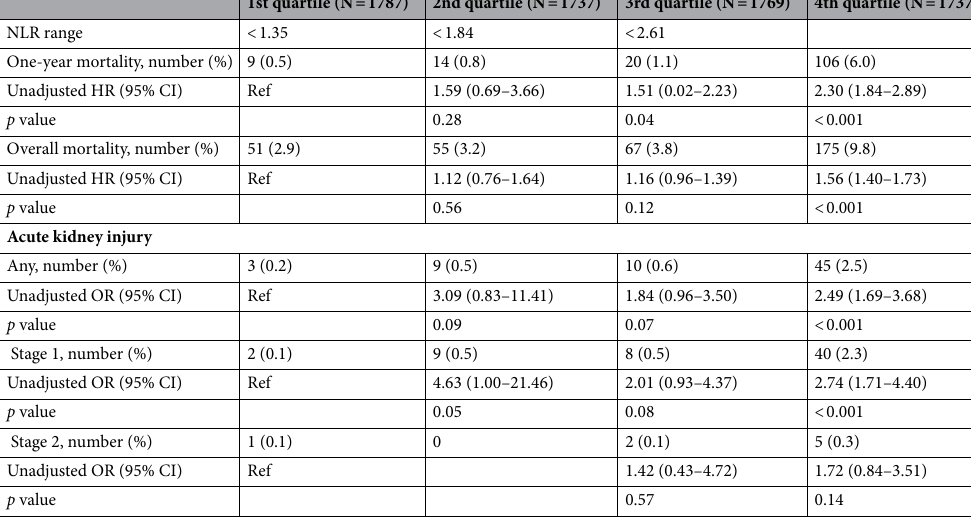
Table 3. Clinical outcomes according to quartile value of preoperative NLR. NLR neutrophil-to-lymphocyte ratio, HR hazard ratio, OR odds